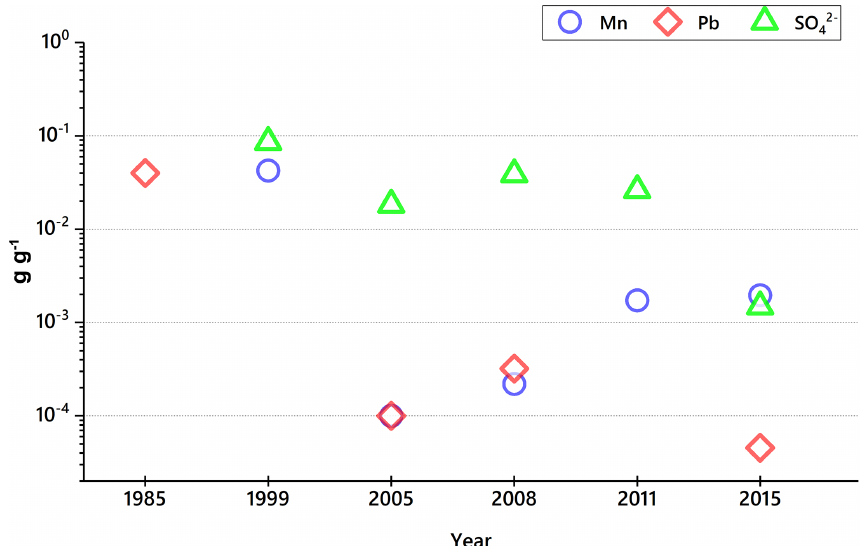
Figure 10. Time series of Mn, Pb, and SO 2 − in PM emitted from vehicles. Data were collated from the Nankai University source library, 4 Dai et al. (1986), Zhang et al. (2000), Bi et al. (2007), Han et al. (2009), Zhang et al. (2009a), Guo et al. (2013), and Li et al.